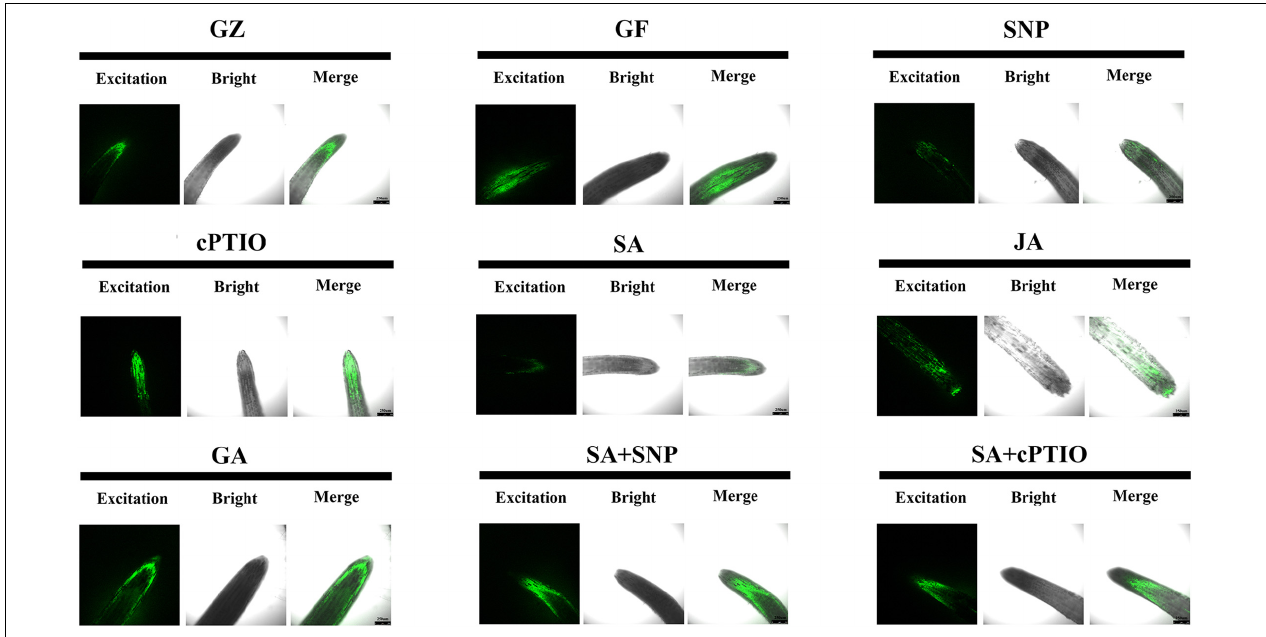
FIGURE 9 | Reactive oxygen species (ROS) accumulation of the roots after the respective treatment of NO effectors and/or phytohormones under the photovoltaic condition (GF) and the normal light condition (GZ), using 10 µ M DCFH-DA as a fluorescent probe. The figure is representative of ten segments stained in each